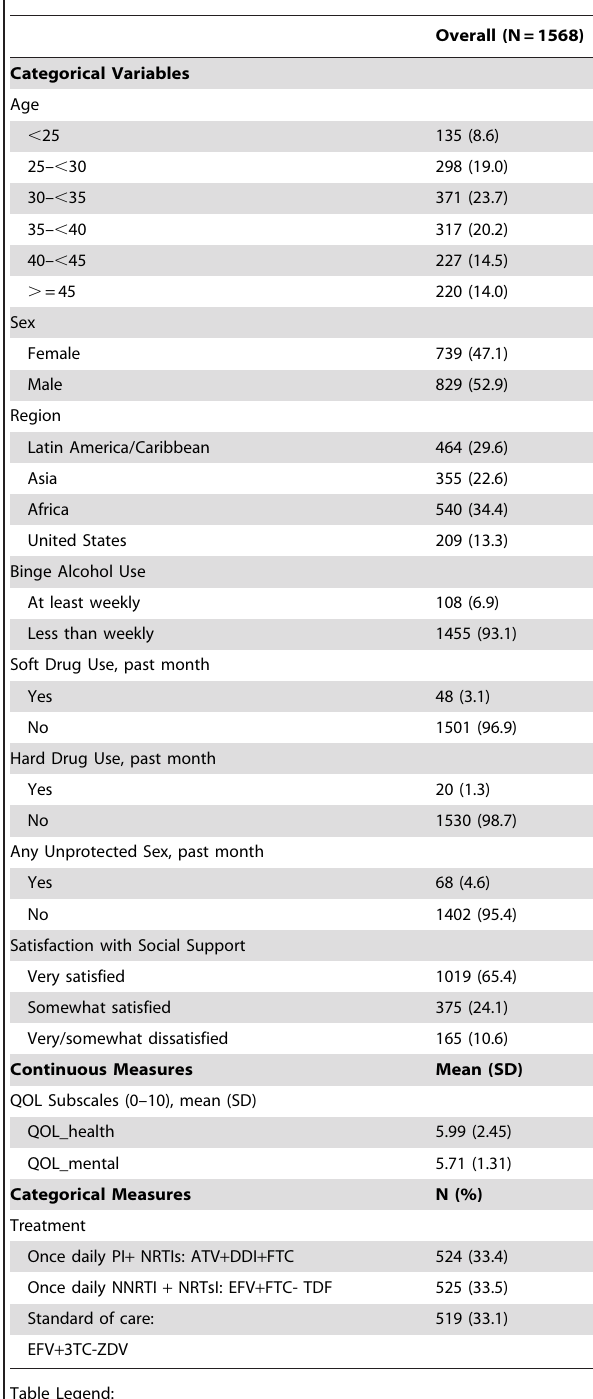
Table Legend: QOL_health: general health